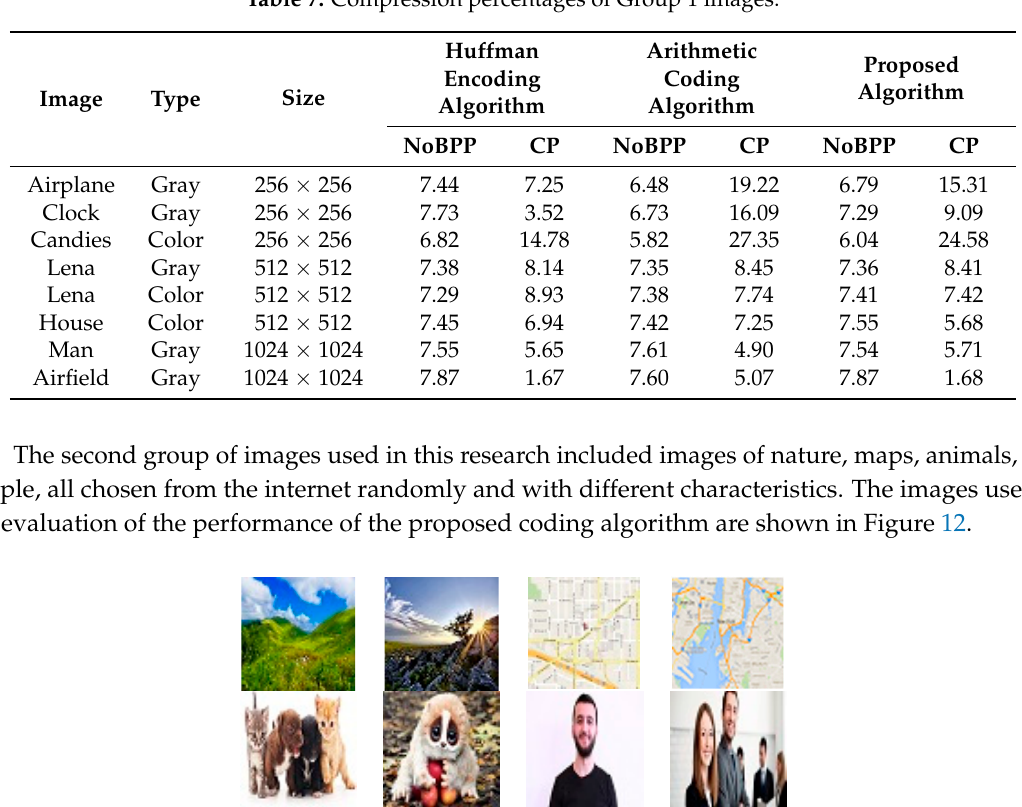
Table 7. Compression percentages of Group 1 images.